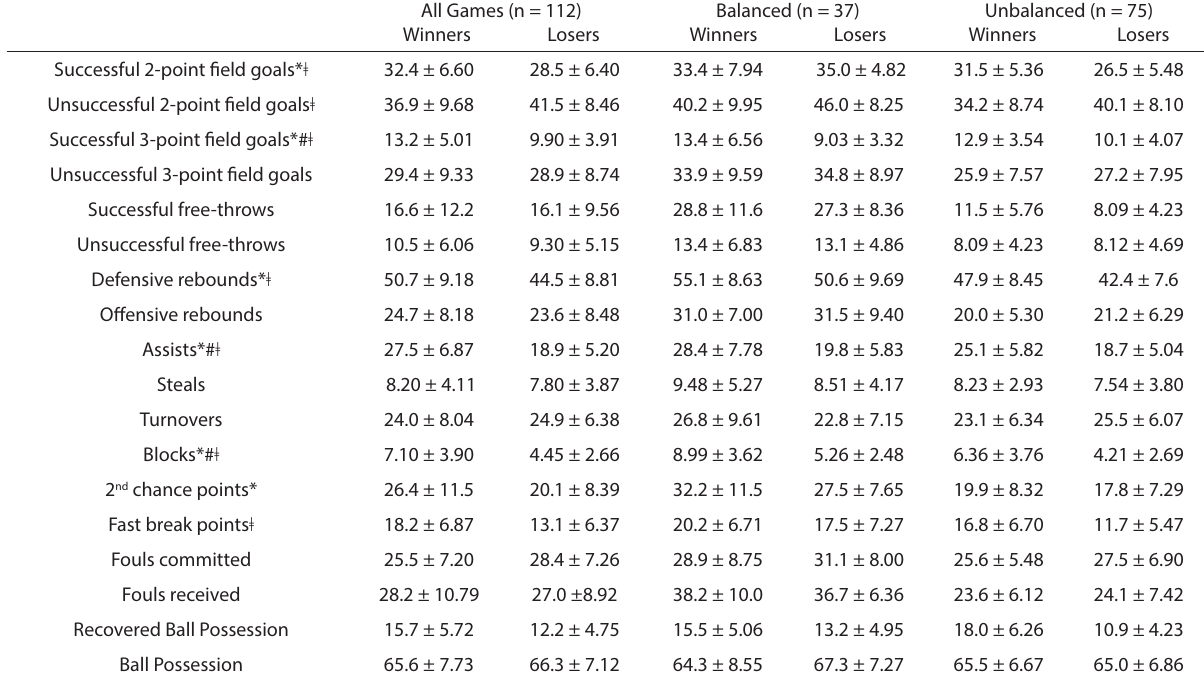
Table 1. Differences in basketball-related statistics